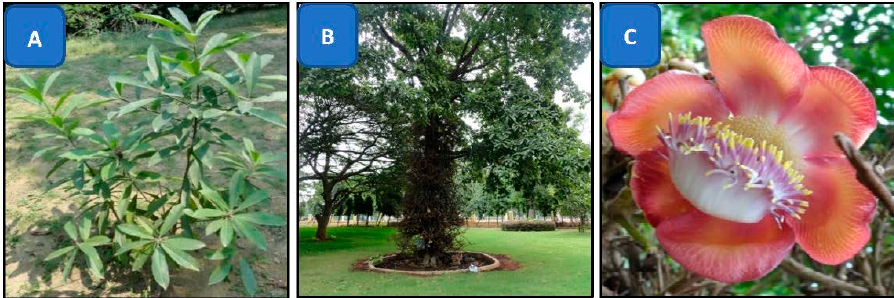
Figure 1. Tree of Couroupita guianensis : ( A ) one year old sapling; ( B ) a mature tree; ( C ) flower.